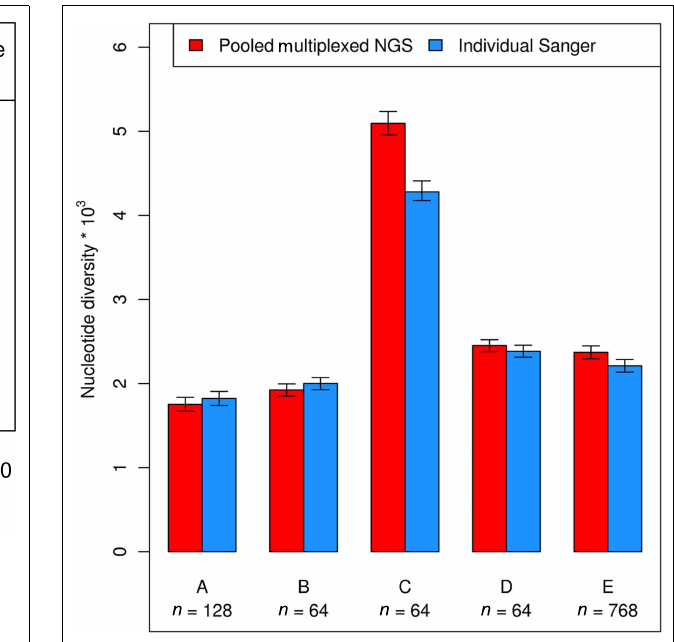
FIGURE 4 | Nucleotide diversity calculated using allele frequency estimated by pooled multiplexed NGS (red bars) and by individual Sanger sequencing (blue